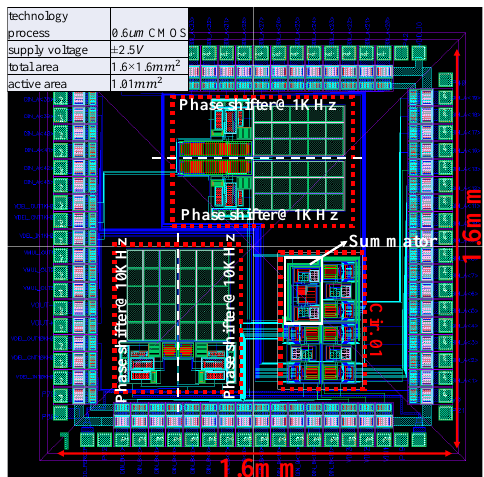
Figure 5. Top-level layout of perceptron